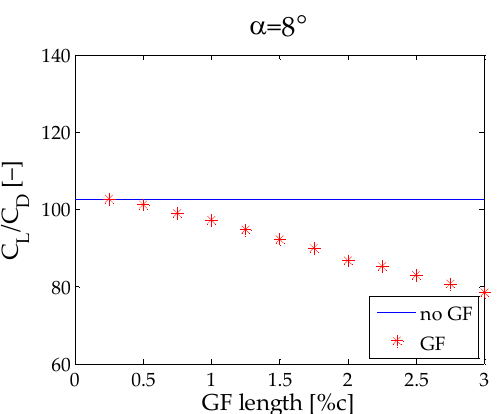
Figure 4. Lift-to-drag ratio (C L /C D ) for the range of AoAs studied in the present work. The C L /C D ratio along the GF length (red asterisks) vs. the clean airfoil (solid blue line) is represented.